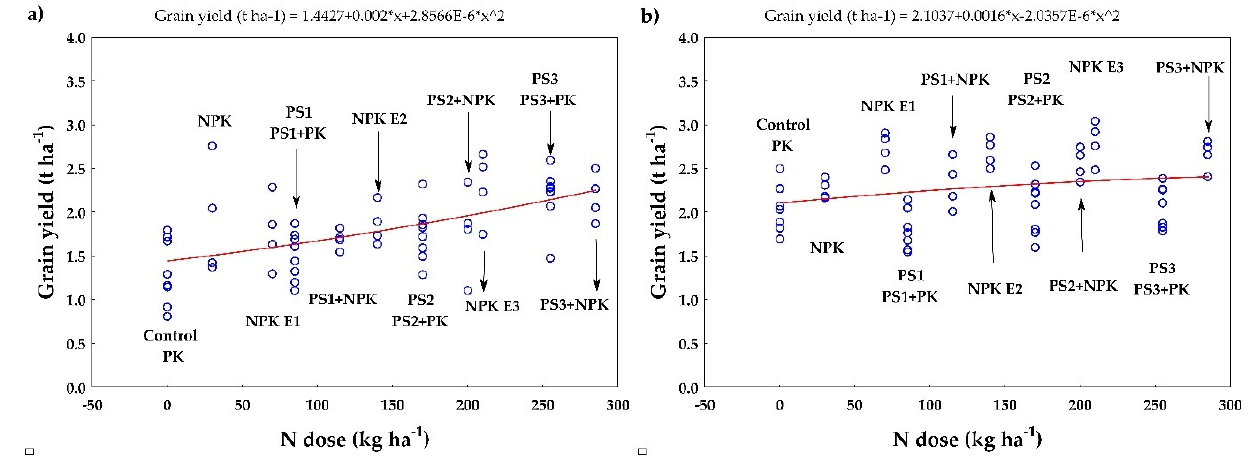
Figure 6. FP grain yield (t ha − 1 ) as affected by N dose in Pernolec in ( a ) 2017 and ( b ) 2020. The average yields (blue points) are interleaved with the quadratic function (red line). The equation of the quadratic model is given above the figure.